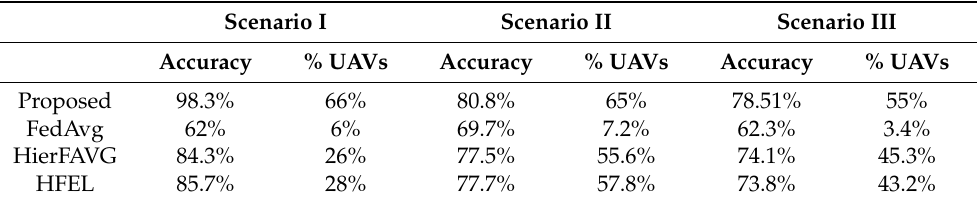
Table 1. Performance comparisons of average test accuracy and the percentage of UAVs reaching the target accuracy of 98% for Scenario I and 80% for Scenario II after 50 global aggregations.